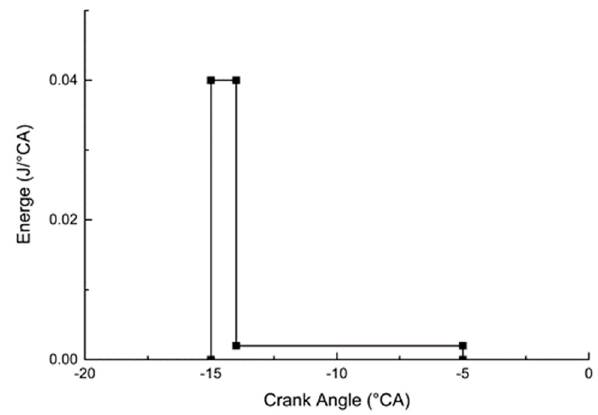
Figure 2. L-type ignition energy.